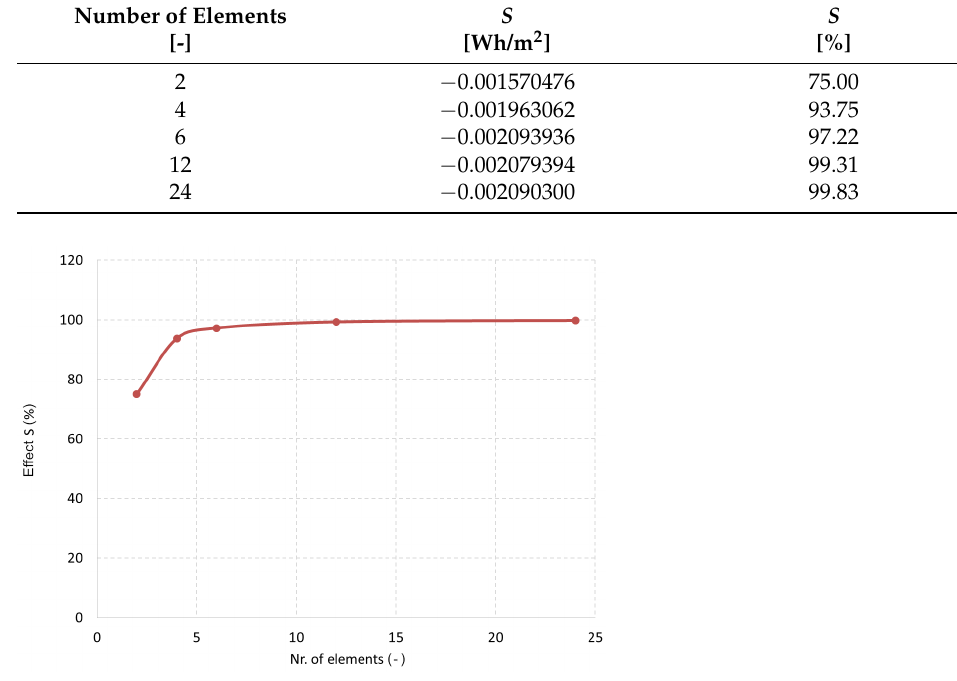
Figure 9. Effect in dependence on the number of used elements (value of 100% was used for the original waveform